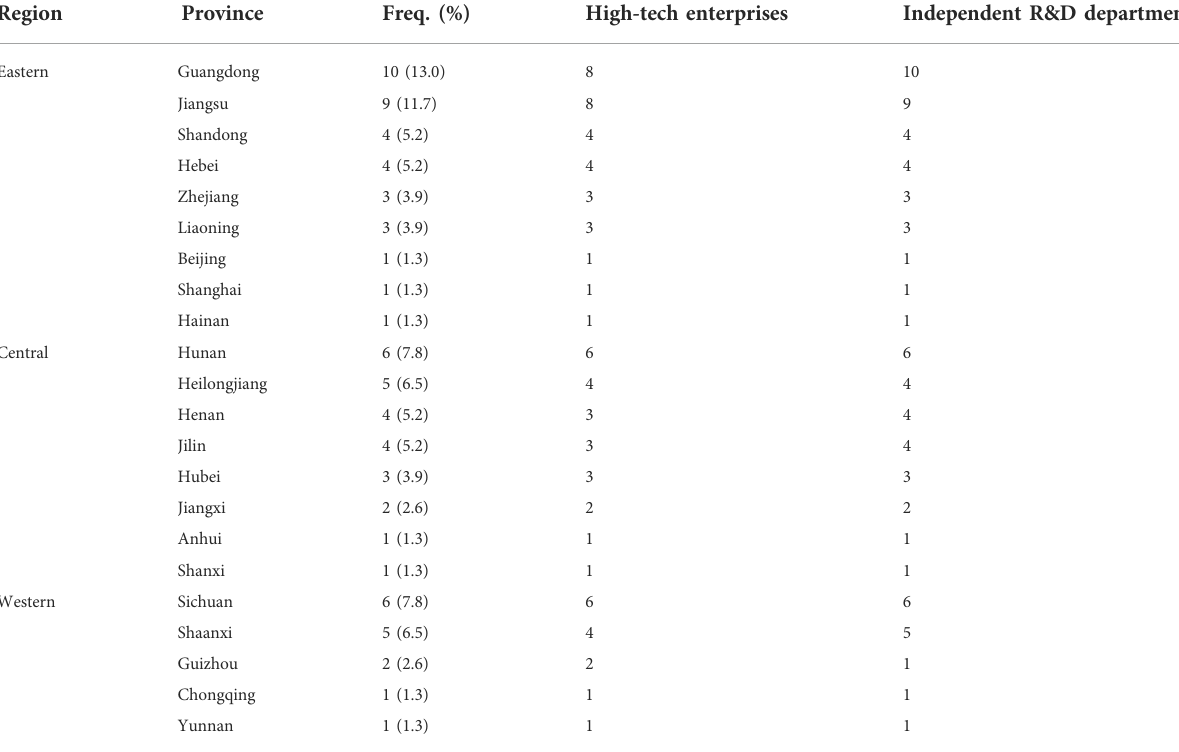
TABLE 1 Geographic distribution of biopharmaceutical enterprises included in this study. Region